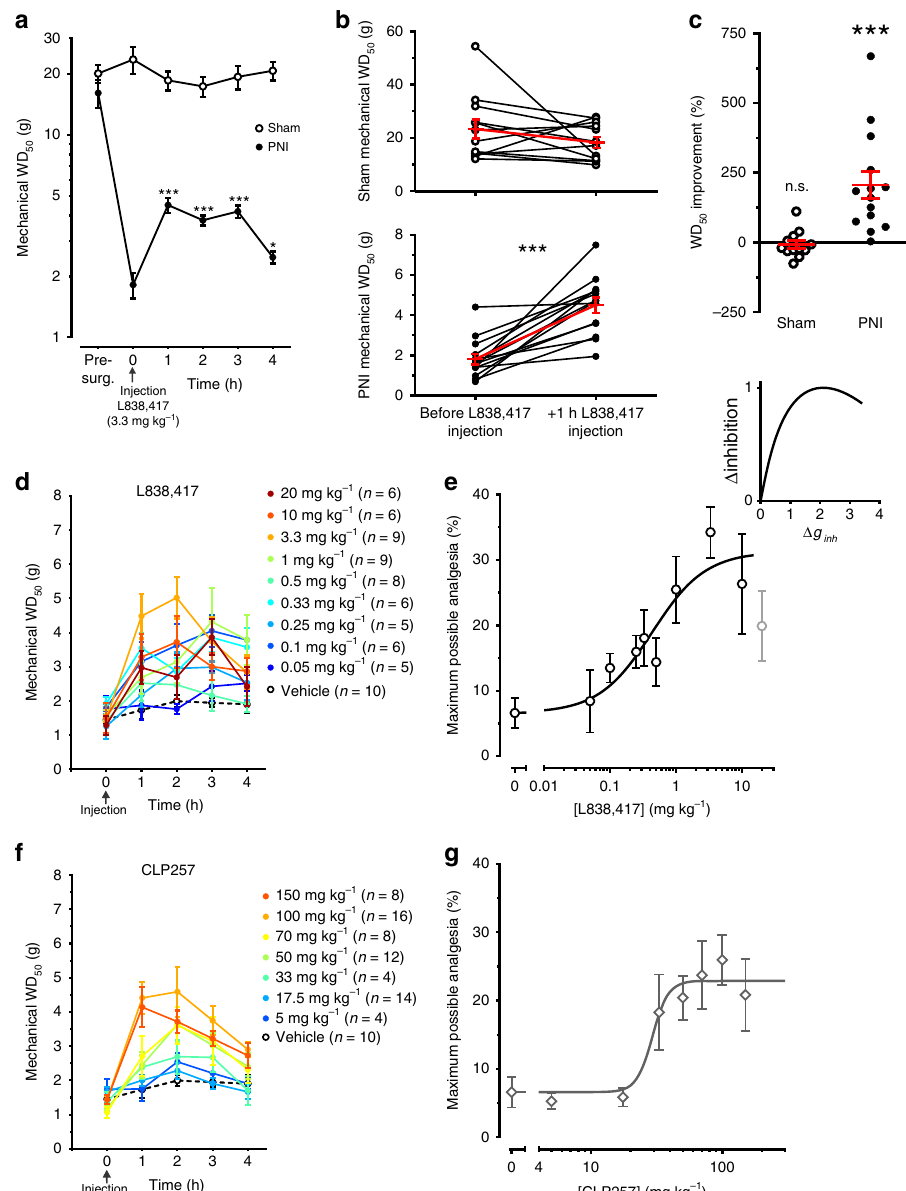
Fig. 4 Pharmacological characterization of L838,417- and CLP257-induced analgesia. a Variations in mechanical WD 50 thresholds over 4 h after IP injection of L838,417 (3.3 mg kg − 1 ) in sham and PNI rats, 14 – 28 day post-surgery. b Mechanical WD 50 thresholds were measured − 1 h/ + 1 h of L838,417 injection in shams and in PNIs. c Percentages of change between the two time points in shams vs. PNIs. d Partial reversal of mechanical allodynia by different doses of IP injected L838,417 in PNI rats. Animals were tested every hour and followed for 4 h. e Dose-response curve of L838,417 in Fig. 4d and fi t curve by the Hill equation with variable slope (Eq. 2 in methods; note that the 20 mg kg − 1 data point was ignored in the fi t as the value was signi fi cantly lower than the one at 3.3 mg kg − 1 ; P < 0.05 paired t -test). Computer simulations ( Inset ) showing a collapse of net hyperpolarizing anionic current when the inhibitory conductance ( g inh ) is increased beyond an optimal point. f Partial reversal of mechanical allodynia by increasing doses of IP injected KCC2 enhancer, CLP257 in PNI rats. g Dose-response curve of CLP257 in Fig. 4f and fi t curve by the Hill equation with variable slope (Eq. 2 in methods). (* P < 0.05; ** P < 0.01; *** P < 0.001). Source data is available as a Source Data fi